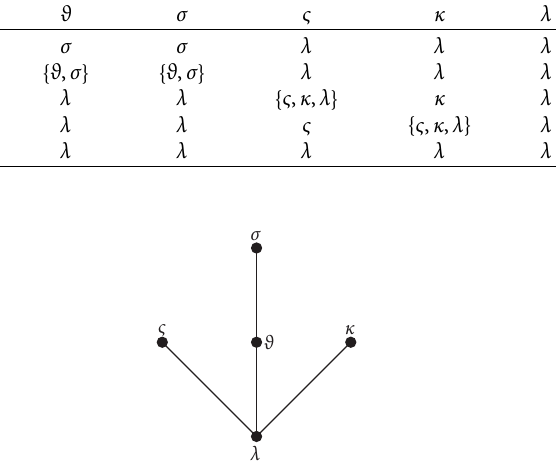
Figure 3: Figure of Θ for Example 3.